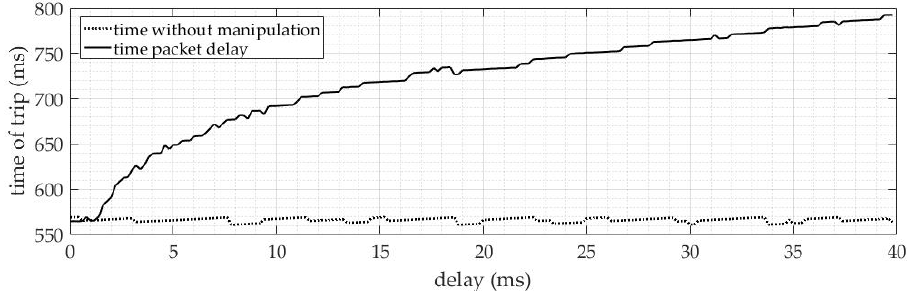
Figure 20. Tripping time results ANSI 51 — delay of SV packets.